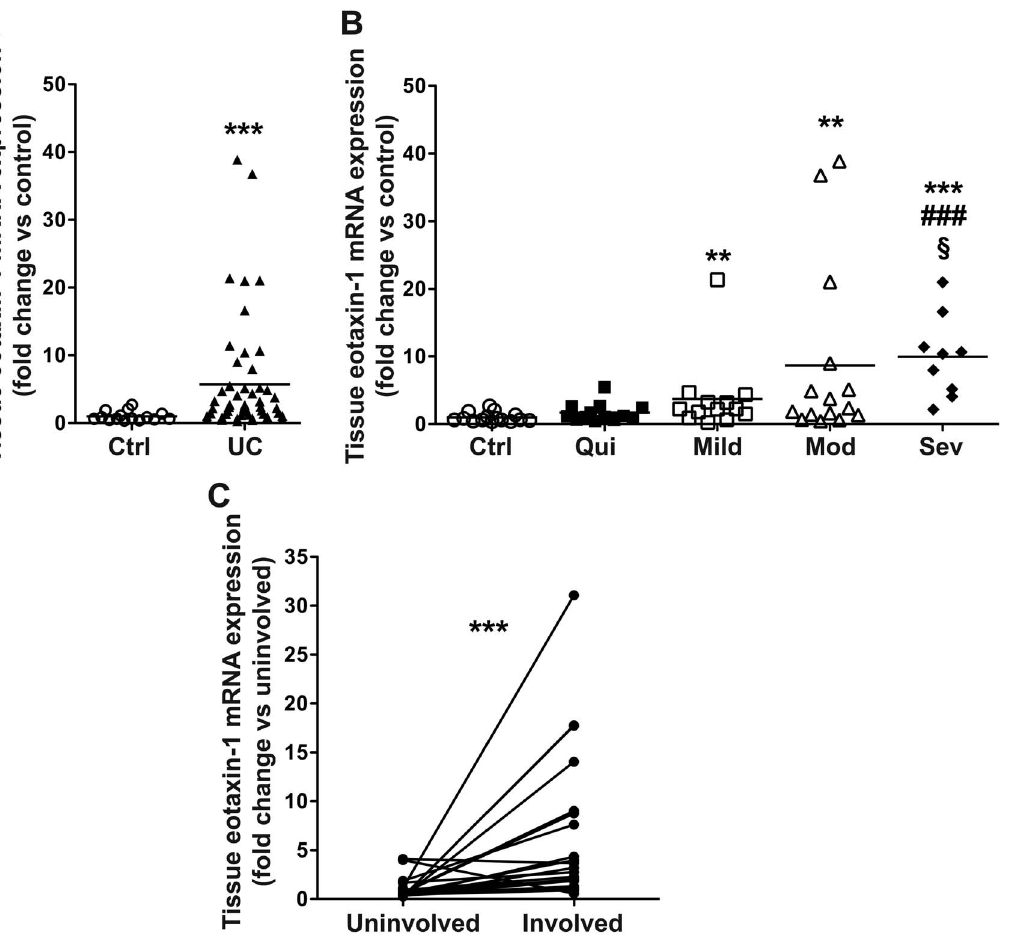
Figure 4. Eotaxin-1 mRNA expression is increased in UC tissues vs. control subjects and in involved vs. uninvolved tissues in UC patients with colitis limited to the left colon. Tissue samples were snap frozen, and subsequently RNA was extracted and mRNA expression assessed by real-time PCR. (A) Eotaxin-1 mRNA levels in control and all UC patients. (B) Eotaxin-1 mRNA levels stratified by UC histologic disease severity. n =22 for controls, and n =46 for UC patients. ** p , 0.01; *** p , 0.001 vs. control. ### p , 0.001 vs. quiescent colitis. 1 p , 0.05 vs. mild colitis. (C) Eotaxin-1 mRNA expression in paired uninvolved (right-sided) tissue and involved (left-sided) tissues. n =21 paired samples from UC patients. *** p , 0.001 vs. paired uninvolved